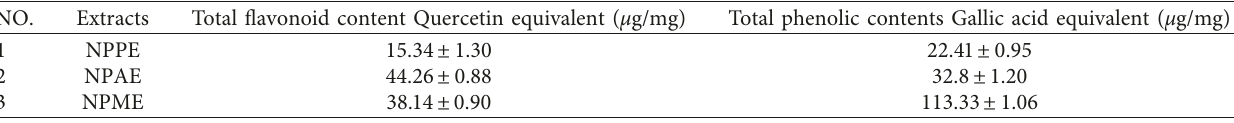
Table 3: Total phenolic and flavonoid contents of the petroleum ether, acetone, and methanol extracts from N. pulmonarioides. NO. Extracts